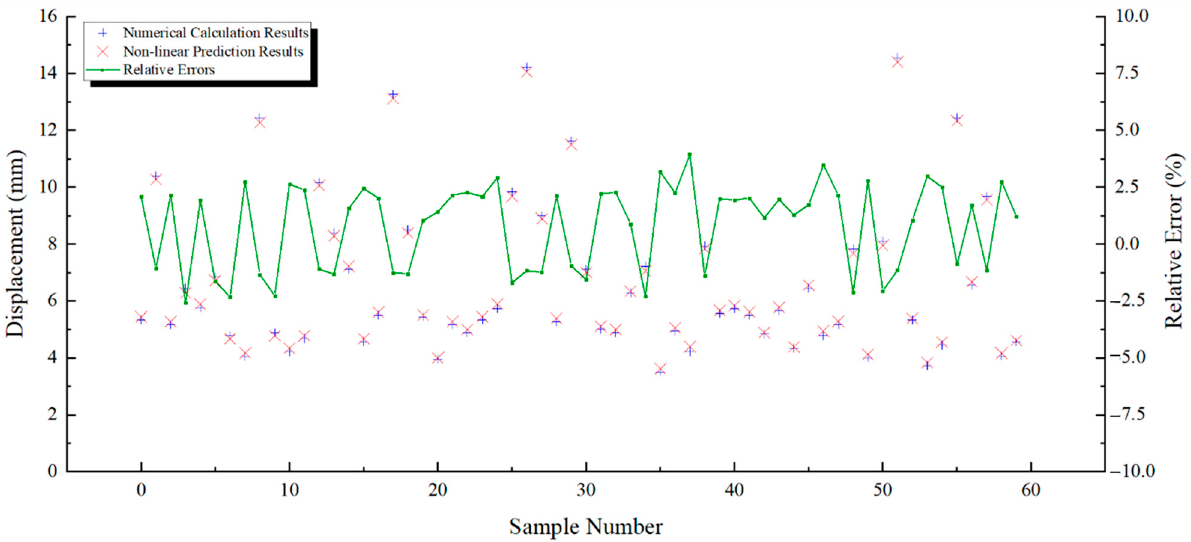
Figure 3. Comparison of nonlinear results and simulation results of displacements.